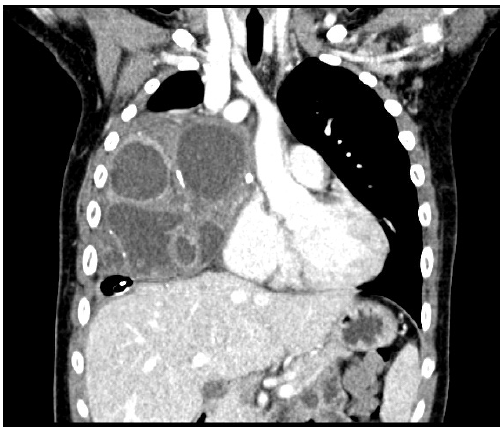
Figure 7. Frontal CT scan of the chest. A bulky and partially calcified mass originating from the anterior mediastinum and expanding into the right hemithorax is seen. The multi-chambered appearance of the mass appears similar to that observed on chest ultrasound. The mass caused a shift of the mediastinal structures to the left and compression of the right lung parenchyma. The middle lobe bronchus was not visualized, probably because it was completely compressed by the mass.